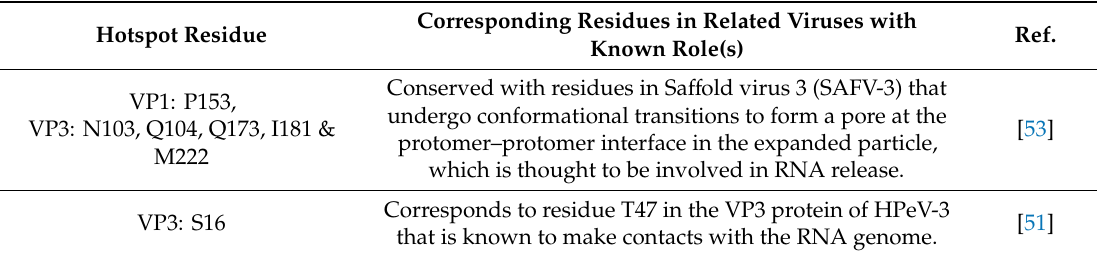
Figure 6. Radial map of the conservation of TMEV interprotomer residues identified as hotspots across respective picornavirus species. The individual TMEV capsid proteins were submitted to ENDScript2 for conservation analysis. The degree of conservation for each TMEV hotspot was compared in eight representative picornaviruses across four genera. Identity of viruses: 1) Cardiovirus B (SAFV; PDB: 5CFC / 5A8F); 2) Cardiovirus A (EMCV; PDB: 2MEV); 3) Senecavirus (SVV-1; PDB: 3CJI); 4) Equine Rhinitis A Virus (ERAV; PDB: 2WFF); 5) Foot-and-mouth disease virus (FMDV; PDB: 5ACA); 6) Enterovirus A (EV-71; PDB: 3VBS); 7) Enterovirus C (PV-1; PDB: 2PLV); 8) Rhinovirus A (HRV-3; PDB: 1RHI). Full alignments are available in Supplementary Figures S1–S4. Table 6. Interprotomer hotspot residues in TMEV conserved with residues in related viruses with previously identified roles.